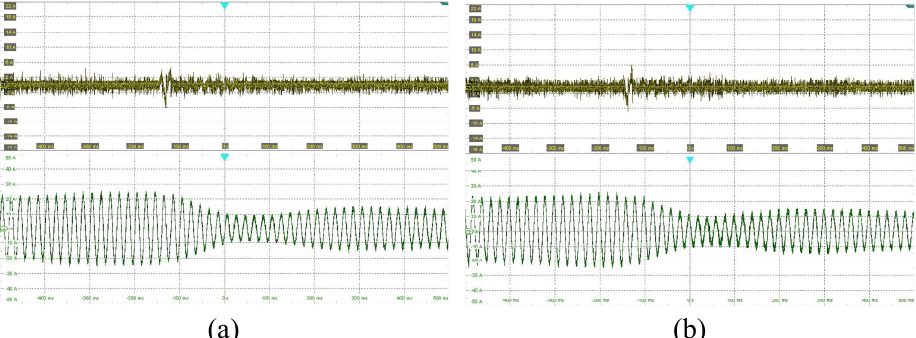
Figure 22. The tracking error and the grid current when the controller is used at 50 Hz. ( a ) VVS. ( b ) CRC.